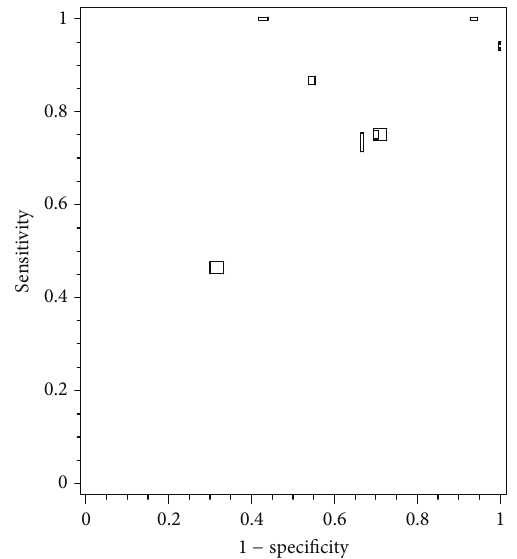
Figure 2: Summary receiver operating characteristics plot for observed accuracy for all individual studies. (Observed accuracy for studies reporting on different cervical length thresholds and definitions of preterm birth were plotted separately).